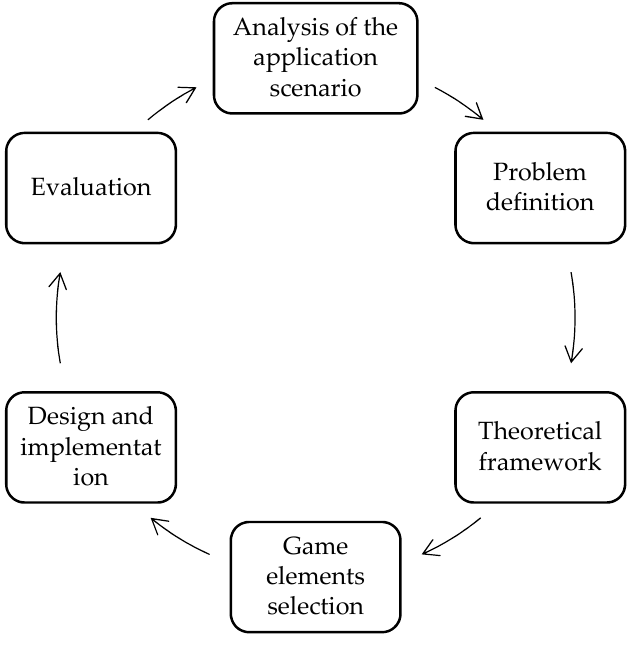
Figure 6. The process of gamification design.